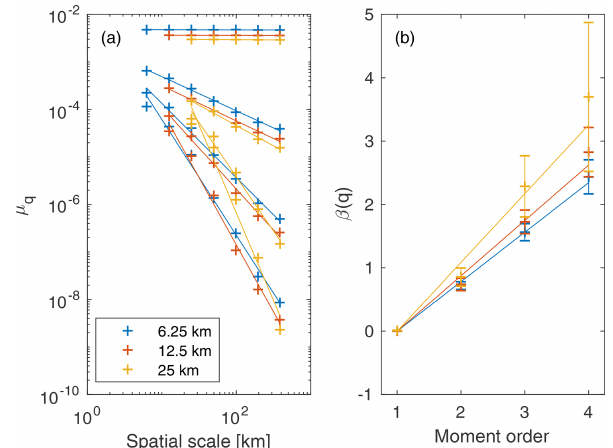
Figure 7. The spatial scaling and structure function of modelled lead fraction in the Central Arctic region over JFM 2007. The two panels are the same as in Fig. 3, but here the colours denote results from runs at different model resolutions.